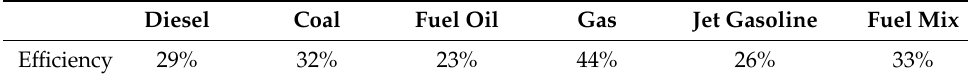
Table 6. The efficiency of power generation plants by technology [43].